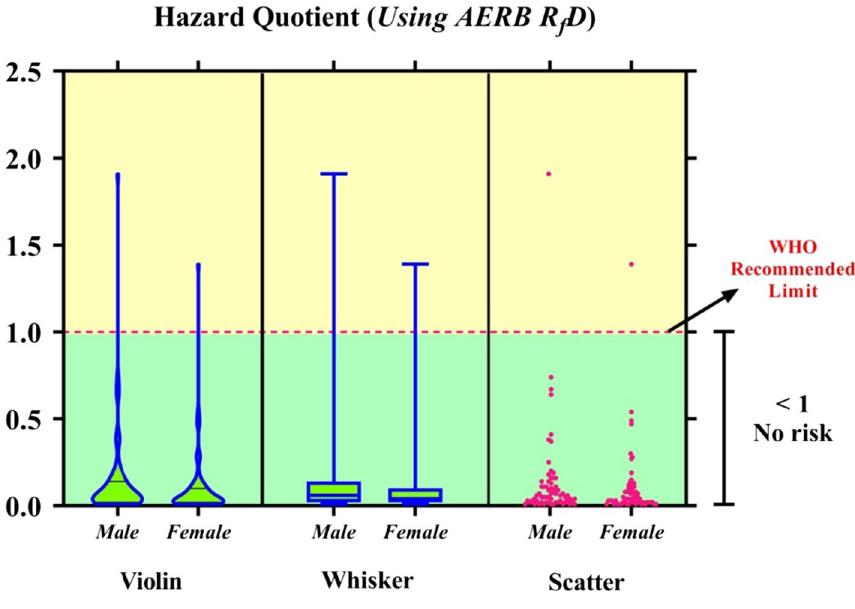
Fig. 18 Frequency distribution of HQ using WHO